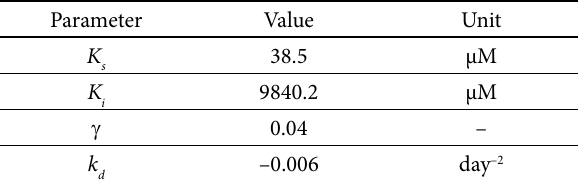
Table 4. The parameters value calculated by nonlinear regression in the first simulation case